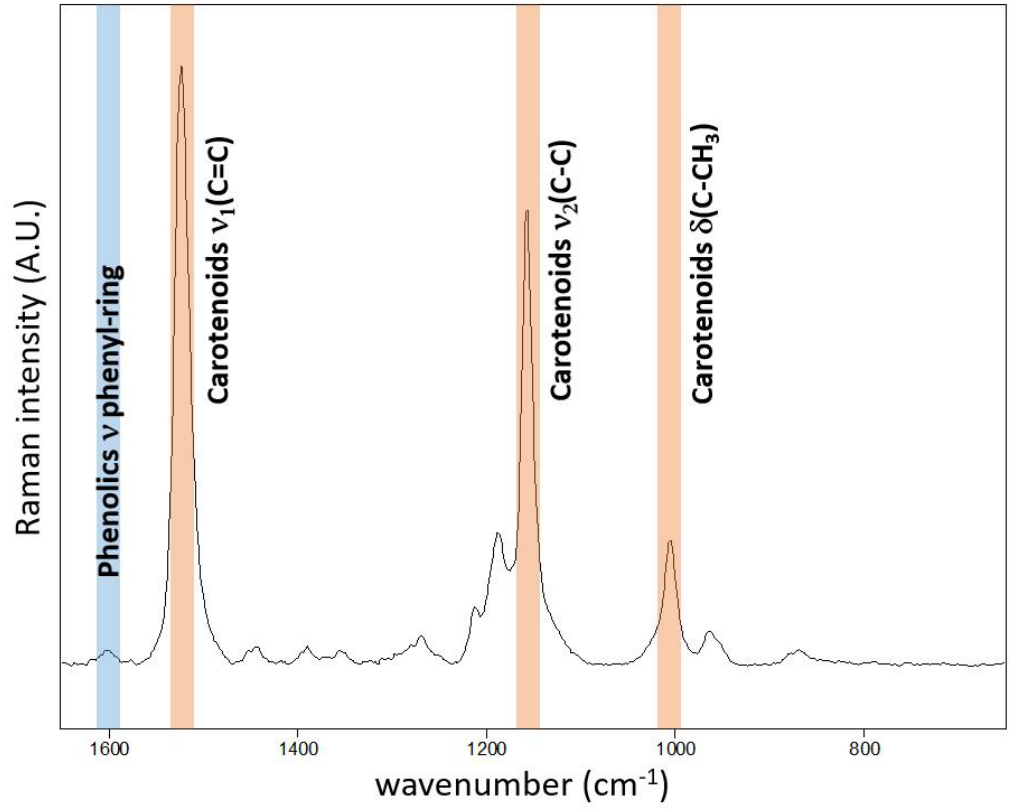
Figure 1. Point Raman spectra obtained at the adaxial surface of Chenopodium album leaf using 514.5 nm excitation wavelength. The spectrum is strongly dominated by resonantly enhanced carotenoid features. Nevertheless, weak features attributed to phenolics are also observed in single-point spectra around 1600 cm − 1